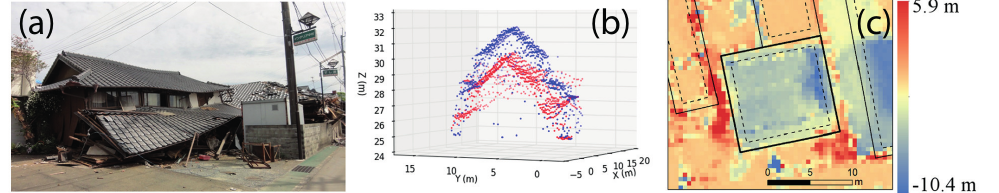
Figure 8. Collapsed buildings during the 2016 Kumamoto earthquake. ( a ) Photo of the collapsed building. ( b ) LiDAR data with before (blue) and after (red) points. ( c ) Elevation difference between the two DSMs. For a detailed discussion see